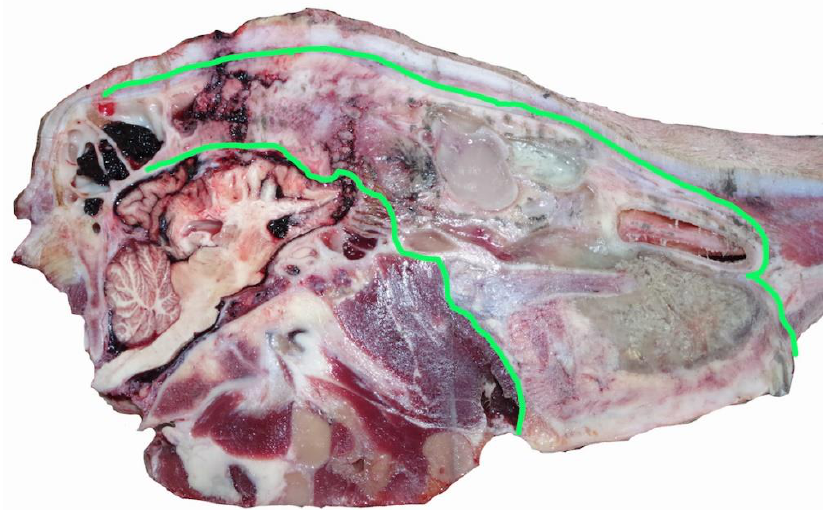
Figure 6. The area of the inflammatory process and chronic fibrous sinusitis with pus formation highlighted in green—left sagittal section.